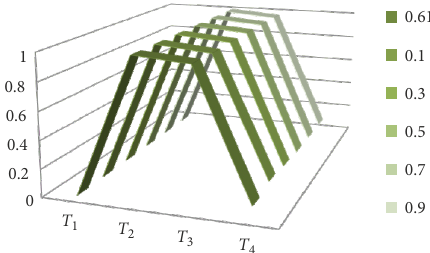
Figure 1. When parameter a changes alone, the results of ℑ ( T k ) in different a